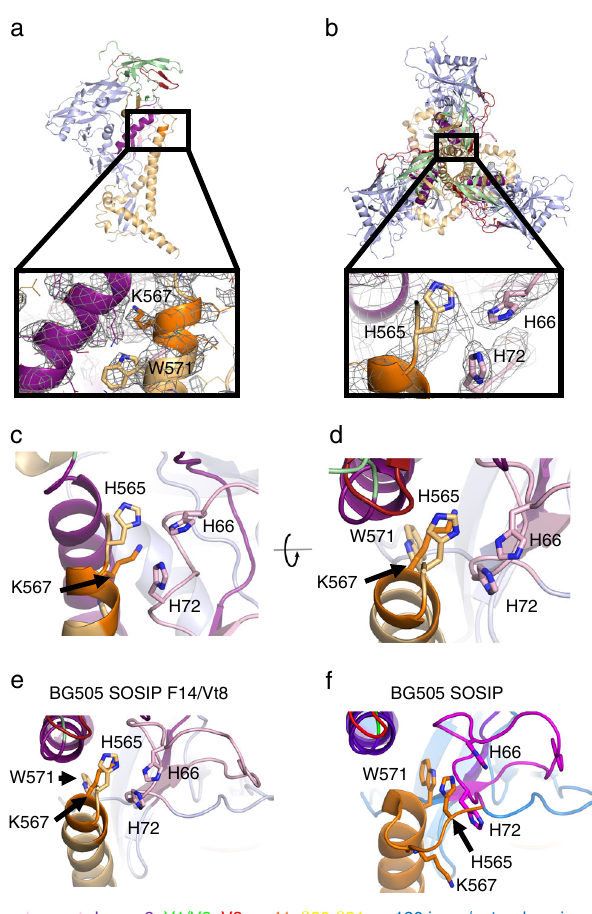
Fig. 4 Atomic level structural details of BG505 F14 and F14/Vt8 SOSIP. a (top) Side view of VRC01 bound BG505 F14 SOSIP, with the rectangle highlighting the location of interior conformational change. (bottom) Zoomed-in view showing the gp41 region around residues K567 and W571 (shown as sticks), with the cryo-EM map shown as a mesh, and the underlying fi tted coordinates in cartoon representation. b (top) VRC01- bound BG505 F14 SOSIP apex-facing trimer orientation, with the rectangle highlighting the location of interior conformational change. (bottom) Zoomed-in view showing the apparent histidine triad (shown as sticks) with the cryo-EM map shown as a mesh, and the underlying fi tted coordinates in cartoon representation. c Side view of histidine triad relative to gp120 and residue K567. The viewing angles in Panels b and c are identical. d Top down view of histidine triad relative to gp120. e , f Comparison between the BG505 F14/Vt8 and BG505 SOSIP layer-1/2 and gp41 HR1